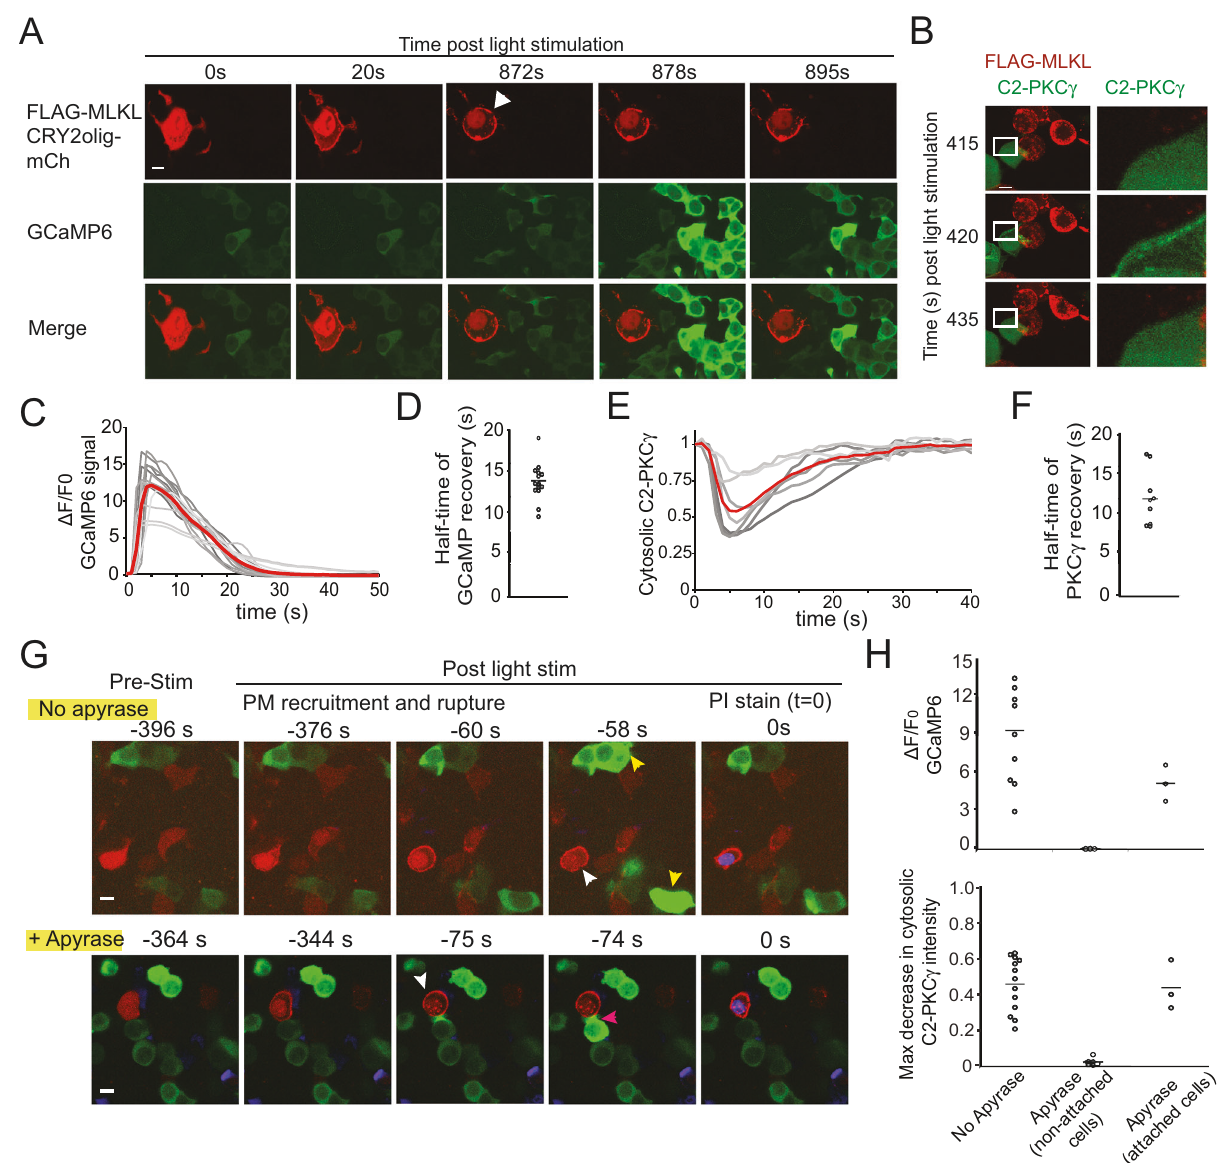
Fig. 4 FLAG-MLKL-induced cell death induces signaling to bystander cells. A Representative images of HEK293T cells were separately transfected with FLAG-MLKL-CRY2olig-mCh or GCaMP6, then mixed at a ratio of 1:5, respectively. Minutes after light stimulation, FLAG-MLKL- expressing cells show membrane rupture (white arrow). Within 6 s after rupture, the surrounding GCaMP6-expressing bystander cells show an increase in Ca 2 + . B Representative images of HEK293T cells separately transfected with FLAG-MLKL-CRY2olig-mCh or PKC γ -C2-GFP, then mixed at a ratio of 1:5. Minutes after light onset, FLAG-MLKL-induced cell death (rounded cell on right side of left panel) triggers transient activation and membrane recruitment of PKC in bystander cells. The zoom of the area in a white rectangle is shown on the right. C Quanti fi cation of change in GCaMP signal ( Δ F / F 0 ) in bystander cells in proximity to dying Flag-MLKL-expressing cell as in ( A ). Time 0 marks the beginning of rise in GCaMP signal, as de fi ned by an increase in baseline > 2 standard deviations from the mean. Thirteen cells were quanti fi ed from n = 3 independent experiments. D Quanti fi cation of the half-time of recovery from peak GCaMP signal from responding cells in ( C ). E Quanti fi cation of change in cytosolic intensity of PKC γ -C2-GFP in bystander cells in proximity to dying FLAG-MLKL-expressing cells as in ( B ). Shown are eight cells from n = 3 independent experiments. F Quanti fi cation of the half-time of recovery from peak cytosolic depletion of PKC γ -C2-GFP, for cells shown in ( E ). G , H Apyrase addition blocks Ca 2 + and PKC γ responses in unattached bystander cells. The experiment was performed as in (A), except cells were incubated with or without 10 U/ml apyrases and used a far-red MLKL (FLAG-MLKL-CRY2olig-miRFP670 nano ) to simultaneously assess MLKL membrane recruitment, nuclear PI staining, and either GCaMP6 or C2 γ -GFP signal. Upon cell rupture (white arrowheads), nearby GCaMP-expressing observer cells (yellow arrowheads) show an increase in Ca 2 + in the absence, but not presence, of apyrase. Cells that are attached to the dying cell (pink arrows) were not affected by apyrase treatment. Representative images are shown in ( G ), with quanti fi cation of the GCaMP (max Δ F / F 0 ) and PKC γ (max cytosolic decrease) responses in bystander cells within 150 µm in ( H ). Data were obtained from 3 independent experiments. Scale bar, 10 μ m (all